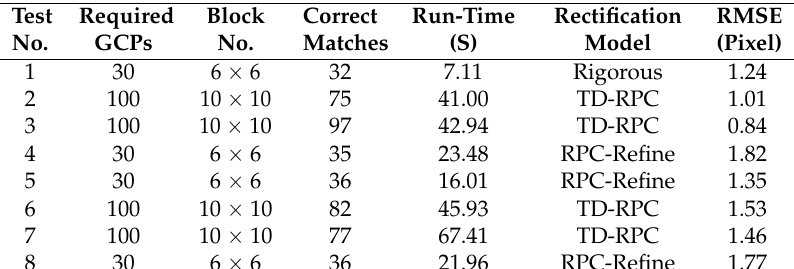
Table 4. Test results of online image matching.